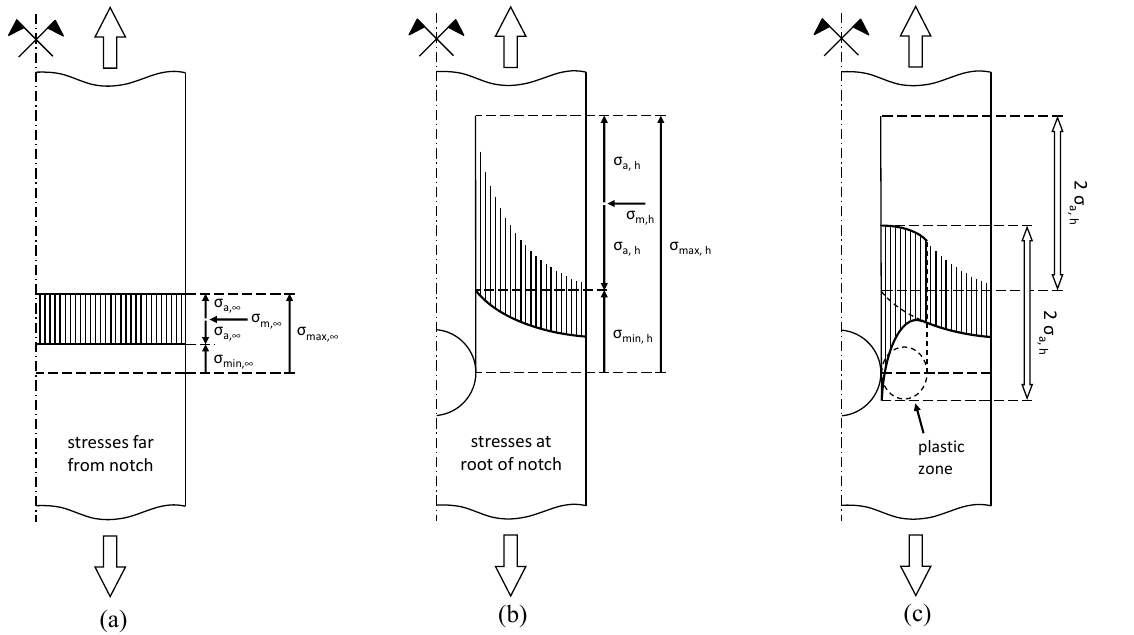
Figure 2. Stresses at ( a ) gross cross-section; ( b ) at notch in elastic and ( c ) plastic range.